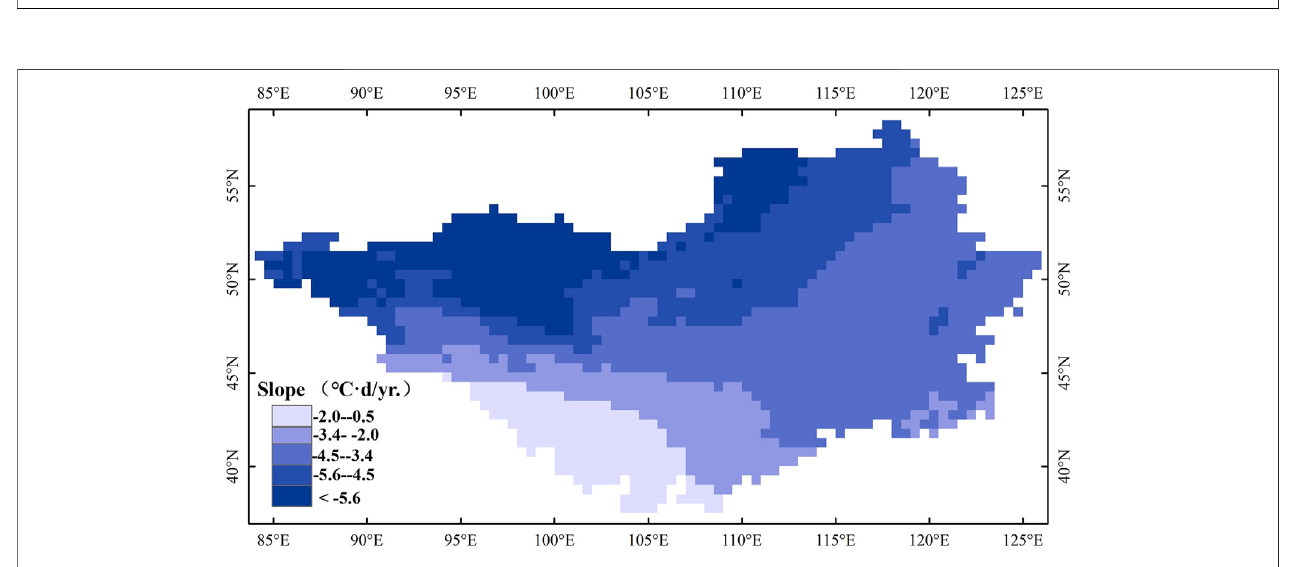
FIGURE 7 | Sen ’ s slope of the freezing index over the Mongolian Plateau from 1901 to 2019.